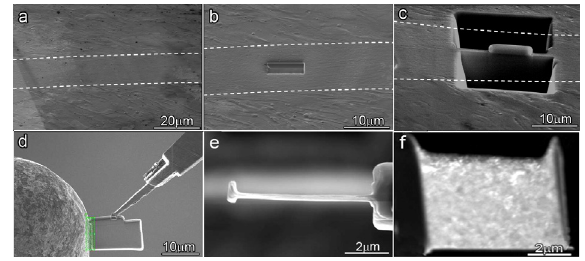
Fig. 5. TEM sample preparation of the microstructure in TBs formed at a strain of 0.30 and a strain rate of 2300 s- 1 : (a) SEM image, (b) deposition Pt, (c) ion-milling, (d) sample transferred by manipulator, (e) TEM sample, (f) TEM image.